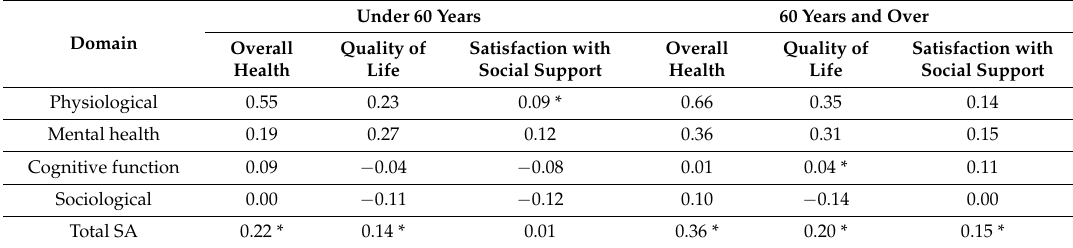
Table 4. Age-stratified correlations of positive self-reported health measures and objective SA domain and total